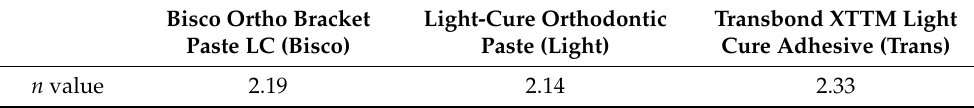
Table 3. Dependence of HV on the applied load for investigated orthodontic composite resins. Bisco Ortho Bracket Light-Cure Orthodontic Transbond XTTM Light Paste LC (Bisco) Paste (Light) Cure Adhesive